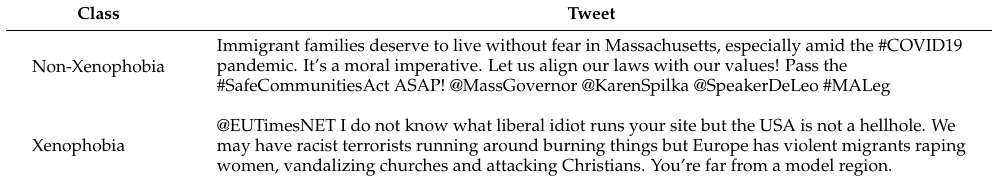
Table 5. Example of tweets belonging to the non-Xenophobia and Xenophobia class.